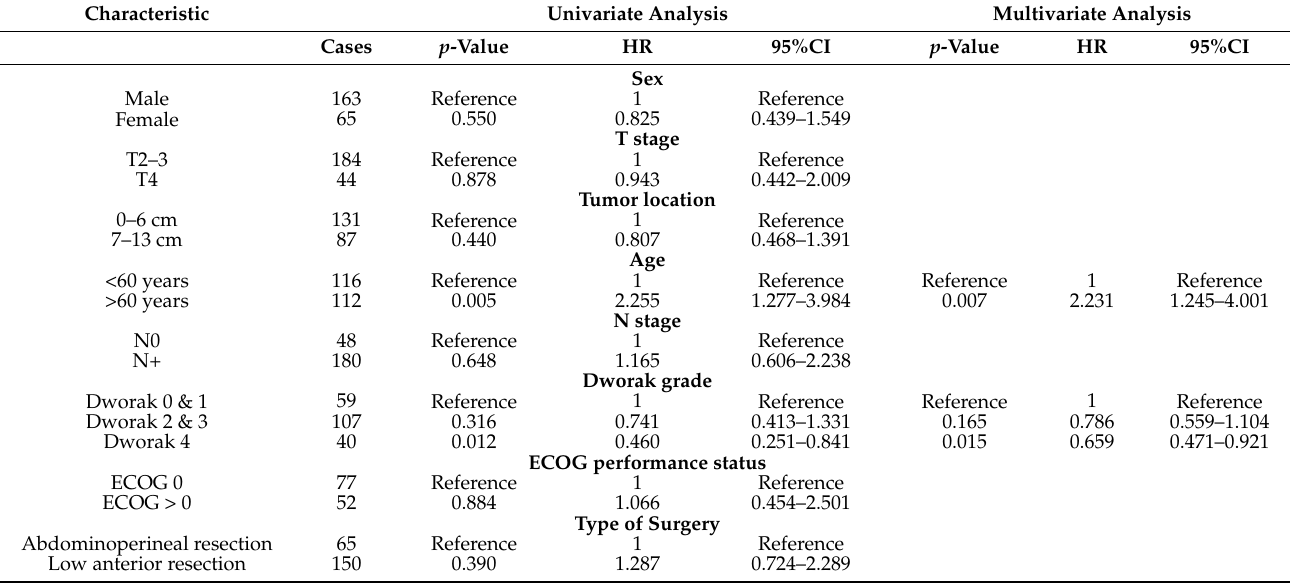
Figure 3. Overall survival and disease-free survival of the study population: ( a ) overall survival by Dworak category before PSM; ( b ) overall survival by Dworak category after PSM; ( c ) disease-free survival by Dworak category after PSM; ( d ) overall survival by age after PSM. Table 2. Prognostic factors: Univariate and multivariate